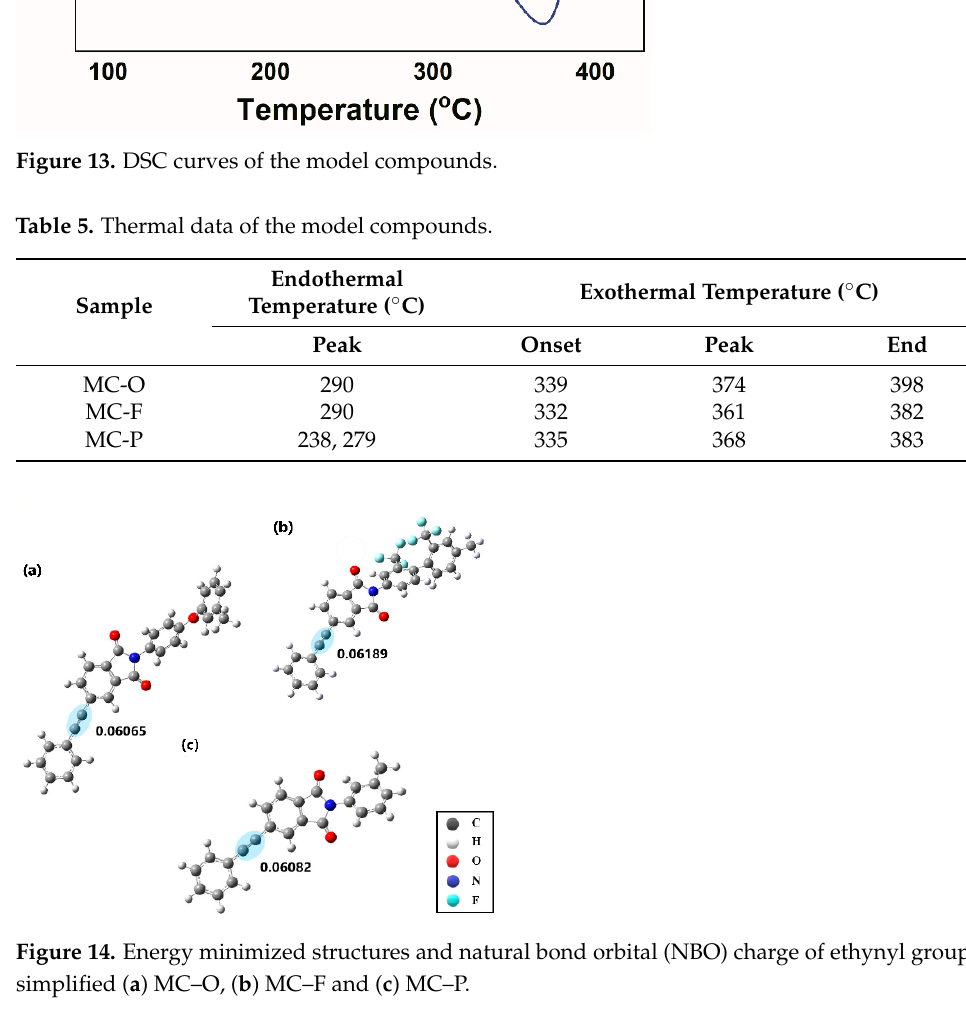
Figure 15. Spin density distribution in ( a ) MC–O, ( b ) MC–F and ( c ) MC–P. The α spin densities are shown in red and the β ones are shown in blue. Table 6. The spin density distribution of the three simplified model compounds. MC-O